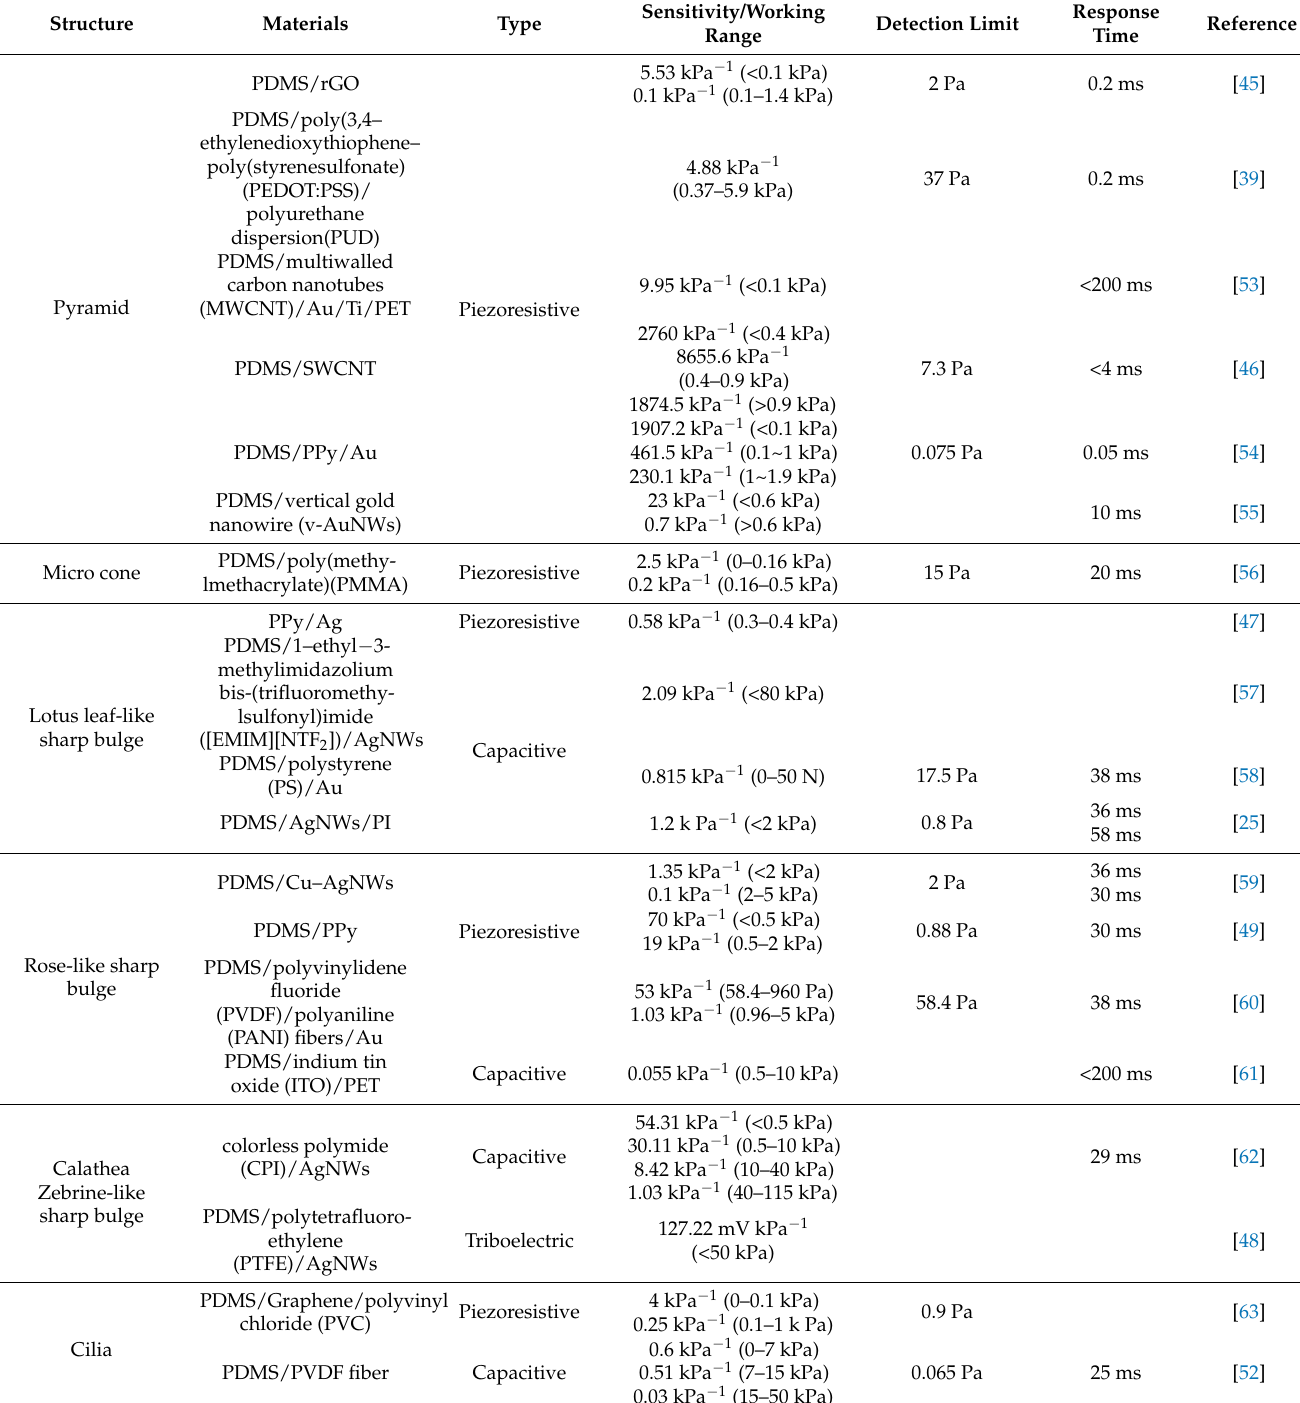
Table 2. The summary of sensor performances with sharp bulge